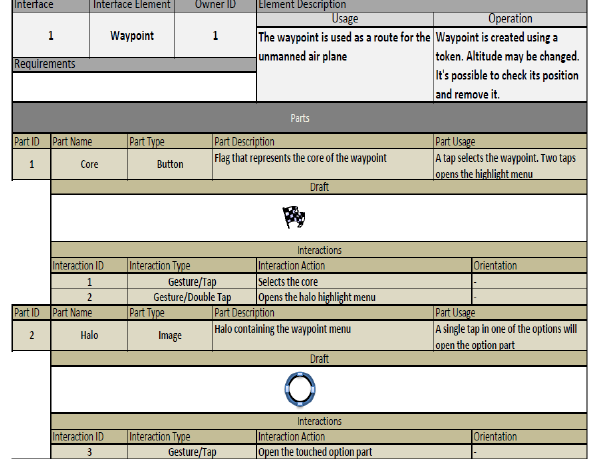
Figure 4. A fragment of the Table-Top Tangible interface